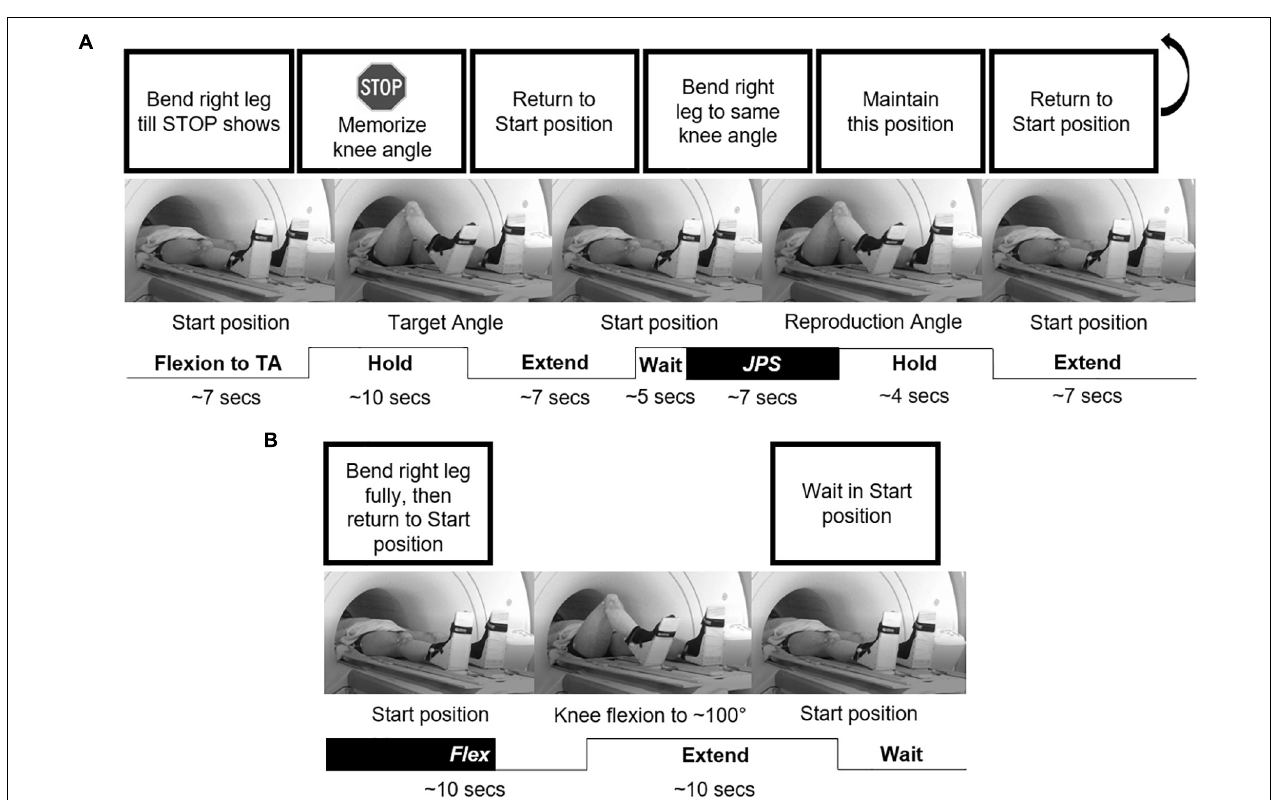
FIGURE 1 | An illustration of the experimental setup. The individual is performing with their right leg (A) one repetition of the JPS test with a target angle of 65 ◦ , and (B) one repetition of the Flex condition. Example instructions shown at the top were displayed on a screen at the rear of the scanner visible to the participant via a tilted mirror attached to the head coil. BOLD response was measured during the highlighted “ JPS ” (from Start position to reproduction angle) and “ Flex ” (from Start position to 65 ◦ knee flexion) blocks, respectively, as well as for a “ Rest ” block (Start position for 15 s). TA, target